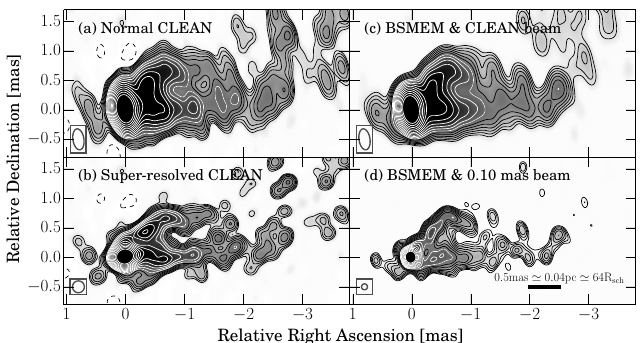
Figure 4. Demonstration of the imaging capability of Bi-Spectrum Maximum Entropy Method (BSMEM) using real 7 mm VLBA data. ( a ) The image obtained from normal CLEAN method (beam: 0.19 0.36 mas, 8.59 ◦ ); ( b ) Super-resolved CLEAN image with a circular beam with FWHM of × 0.20 mas; ( c ) The source image reconstructed by BSMEM and convolved with the beam of the normal CLEAN result; ( d ) A BSMEM map convolved with a circular beam of 0.10 mas in size. The beam sizes are shown at the left bottom corners. Except for panel ( d ), the minimum contour level is 1.0 mJy/beam. For panel ( d ), it is 0.5 mJy/beam. The other parameters for the display are the